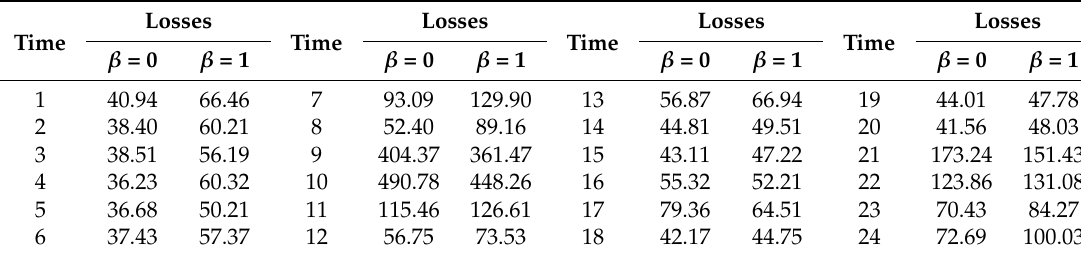
Table 8. The amount of the losses